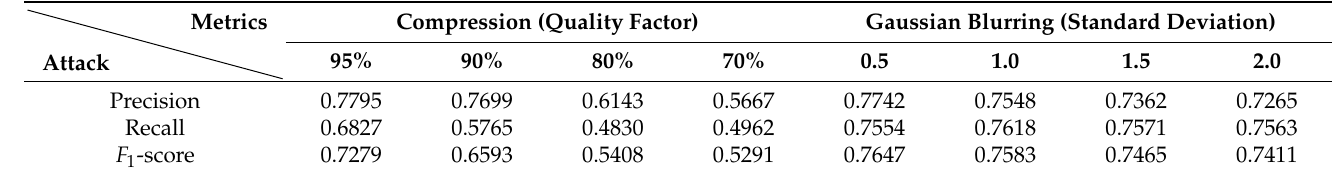
Table 3. Tampering detection results of CASIA1.0 under compression and blurring